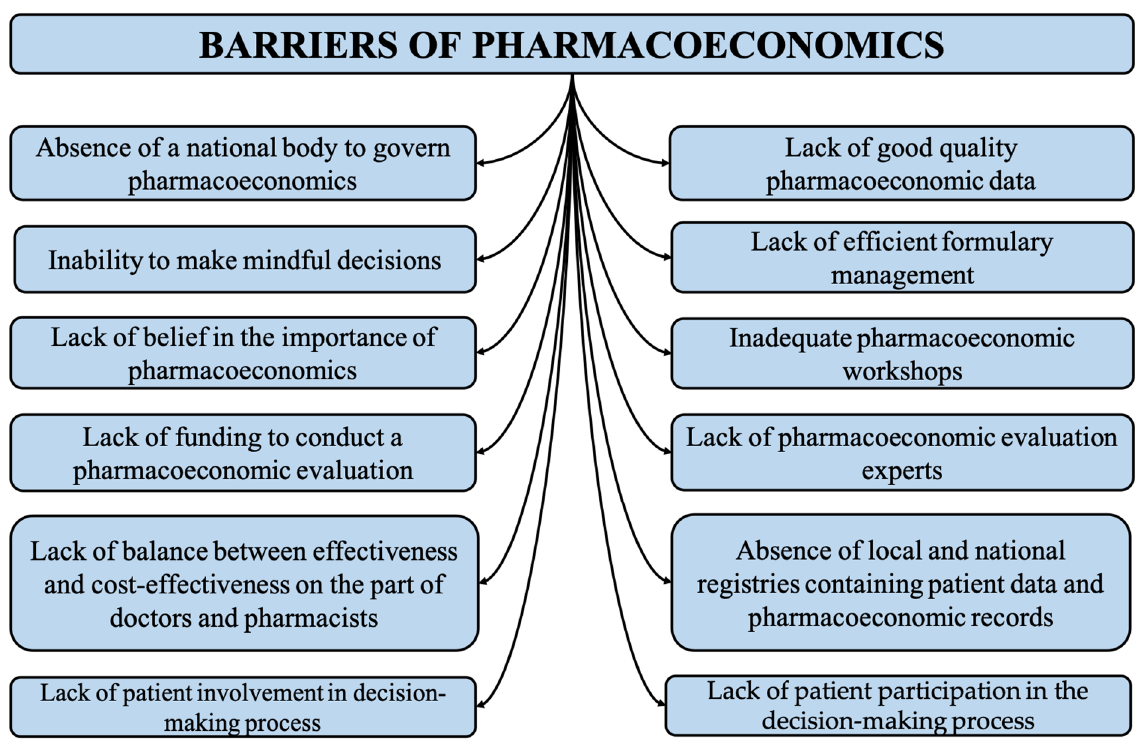
Figure 1. Illustrating major barriers of pharmacoeconomic studies; however, other barriers were discussed in the discussion, such as lack of awareness among audience and